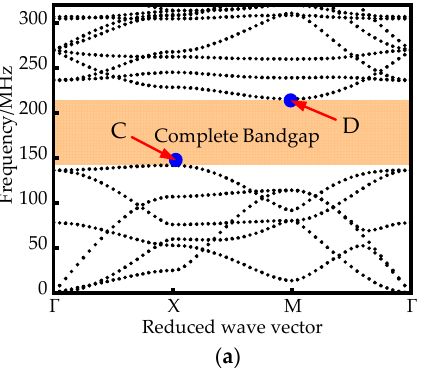
Figure 3. ( a ) Traditional PnC dispersion curve ( b ) Vibration mode diagram of the start and end points of the band gap (The arrow represents the size and direction of the displacement).